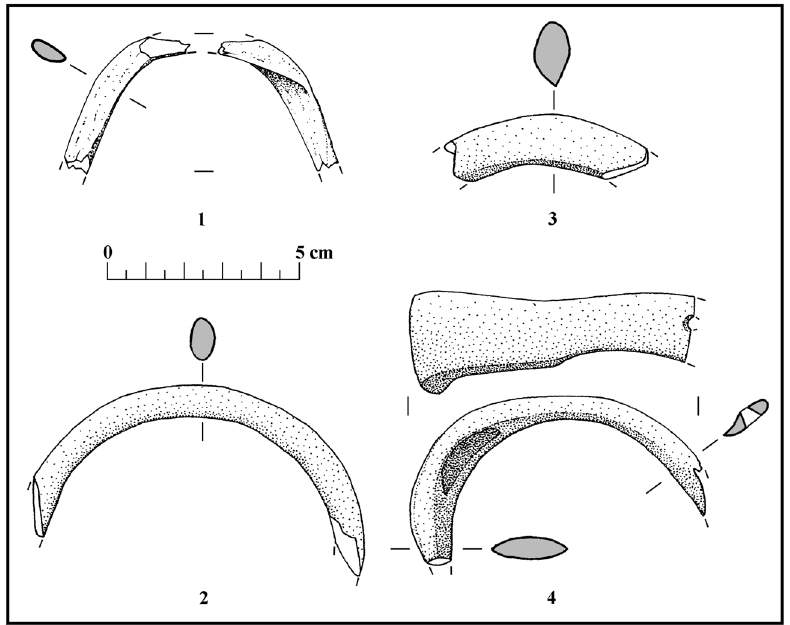
Figure 5: Shell ring bracelets: ( 1 ) Torre Sabea, Glycymeris sp. shell ( Early Impressed Ware group ) ; ( 2 ) Ca ’ Bissara, Glycymeris sp. shell ( Impressed Ware - Fiorano mixed context ) ; ( 3 ) Fornaci Carani - Fiorano Modenese ( Fiorano group ) , Spondylus gaeder - opus shell; ( 4 ) Isorella - Cascina Bocche ( Vhò group ) , Spondylus gaederopus shell (( 1 ) after Micheli, 2002; ( 2 – 4 ) after Micheli, 2006 )